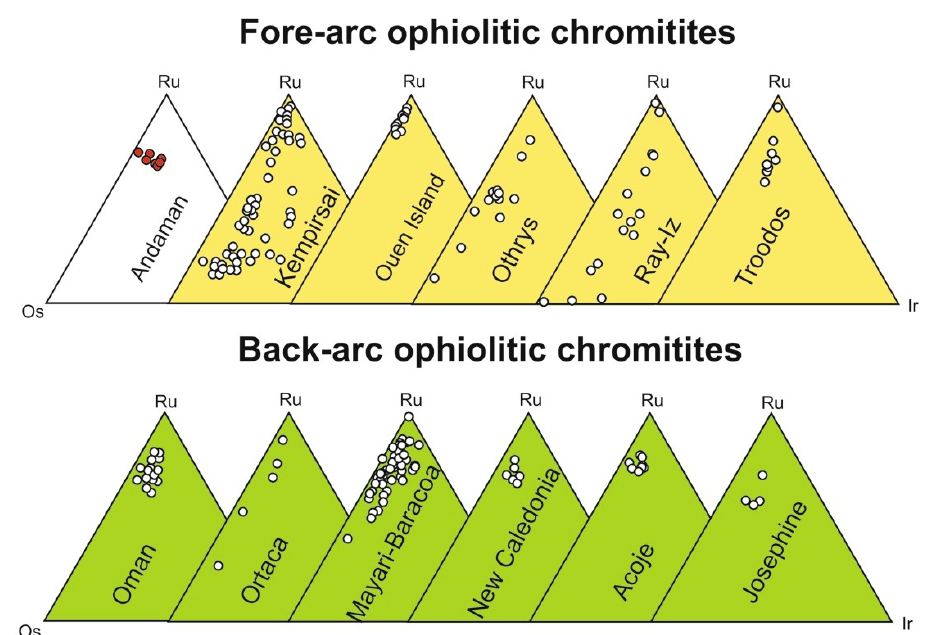
Figure 5. Composition of inclusions of laurite analyzed in this study and comparison with those minerals of the laurite (RuS 2 )–erlichmanite (OsS 2 ) solid solution series in chromite grains in chromitites from different ophiolite complexes, plotted in Ru-Os-Ir (atomic %) ternary diagrams. The data for these plots are from the compilation by [71].